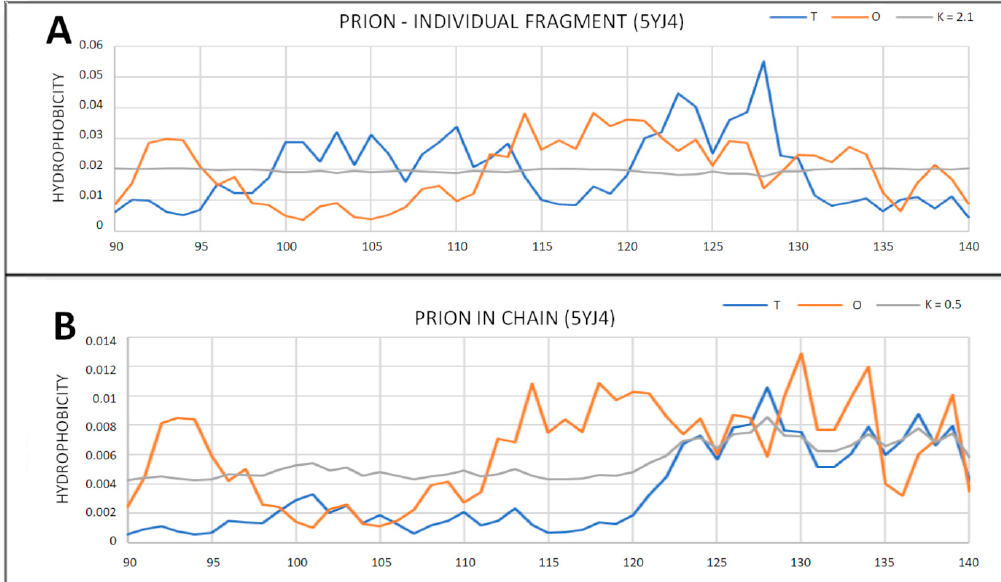
Figure 6. T, O and M profiles for prions with a partially unfolded N-terminal fragment as observed in 5YJ4. ( A ) Complete chain; ( B ) N-terminal segment.